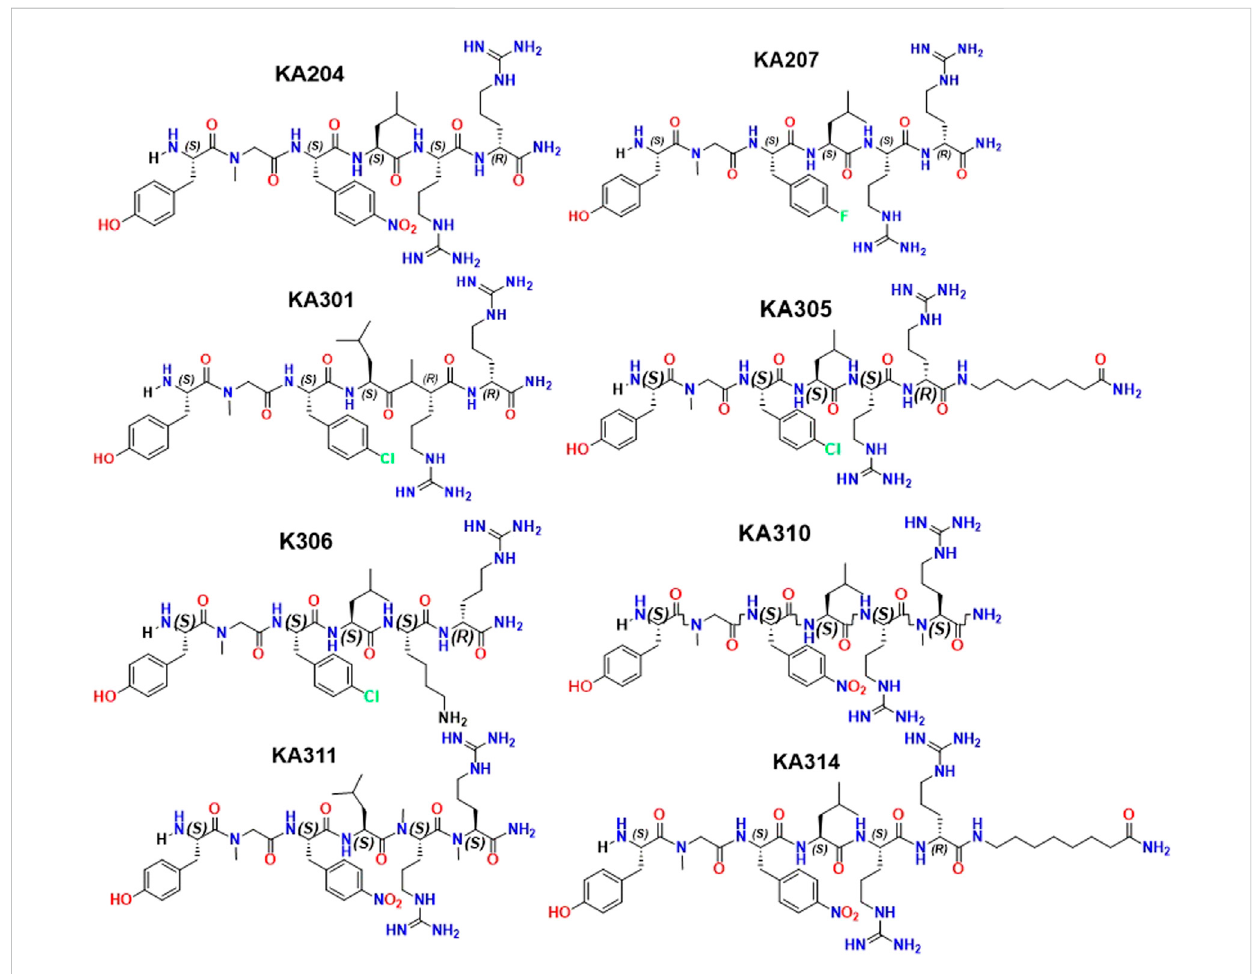
FIGURE 3 Structures of selected peptide